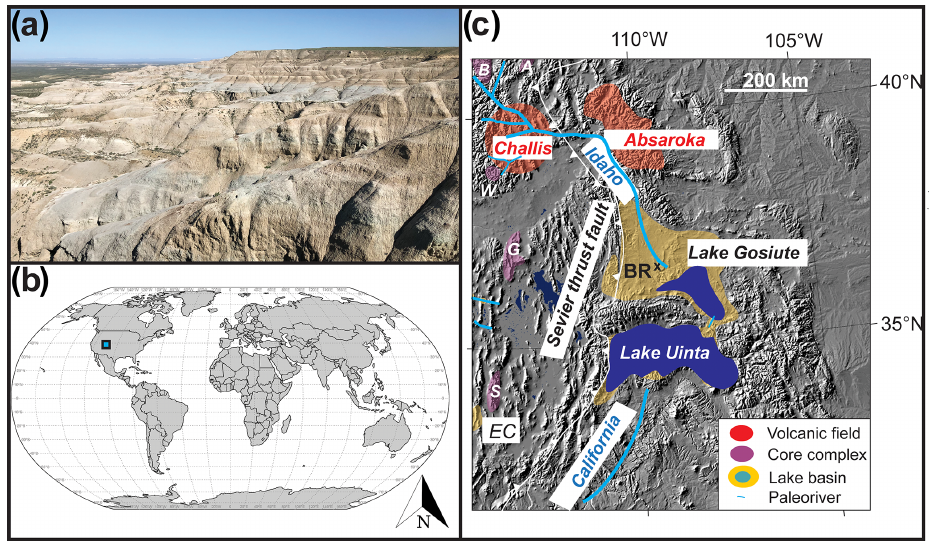
Figure 3. Map and profile of the Blue Rim escarpment. (a) Landscape image of the escarpment from the uppermost strata. (b) Location of the Blue Rim escarpment (blue square) at present in the context of the present tectonic configuration of the world using a Robinson projection map. (c) Shaded relief map of the North American Cordillera showing the paleogeographic position of the Blue Rim (BR) relative to major paleorivers, lake basins, and tectonic elements. EC refers to early Bridgerian Elderberry Canyon local fauna of Emry (1990). Core complexes occur near the Cordilleran paleodivide: B – Bitterroot; A – Anaconda; W – Wildhorse; G – Albion–Raft River–Grouse Creek; S – Snake. Note that the Bridger Formation at Blue Rim represents the topsets of the Sand Butte delta (see Smith et al., 2008). Paleorivers are summarized from Henry et al. (2012), Dickinson et al. (2012), and Chetel et al. (2011).